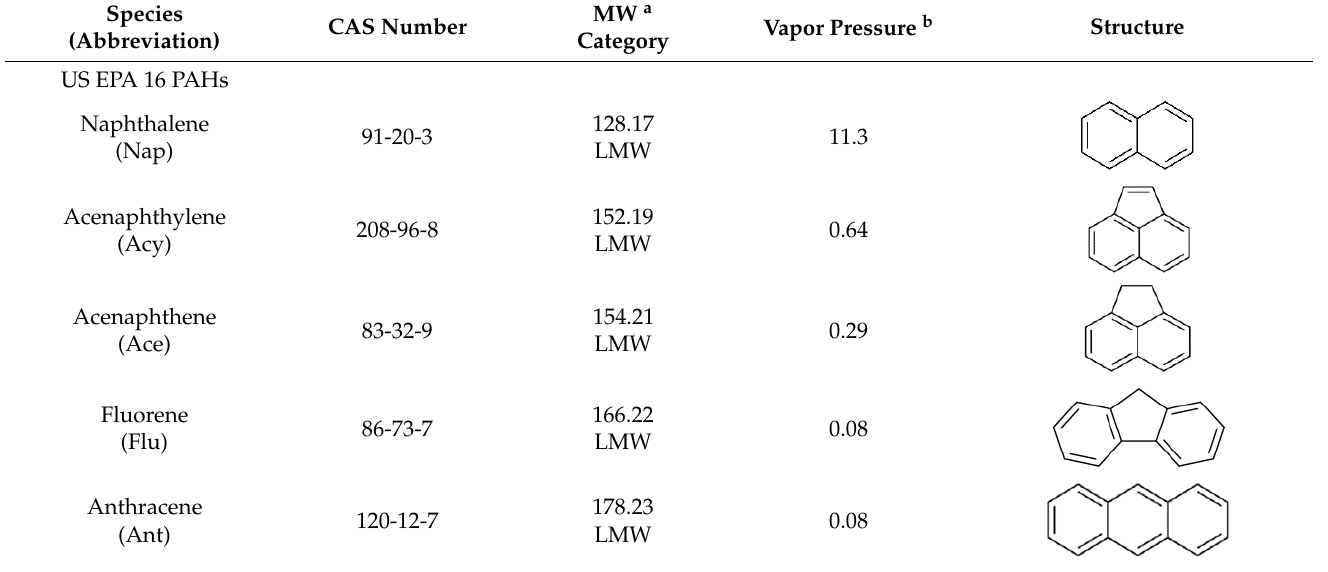
Table 2. Information of US EPA 16 PAHs and non-priority PAHs.